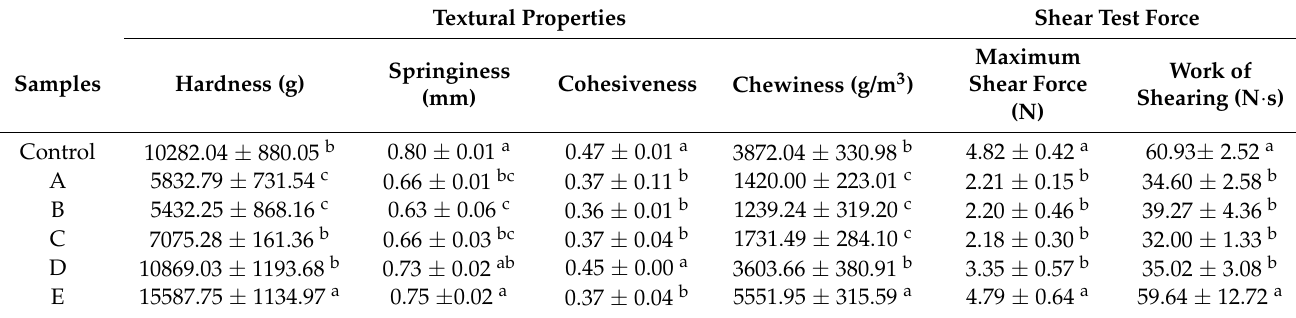
Table 3. The textural properties and shear test force of the fat-replaced samples with palm shortenings (PS) of various melting ranges (MR) as compared to the control sample with chicken skin. Textural